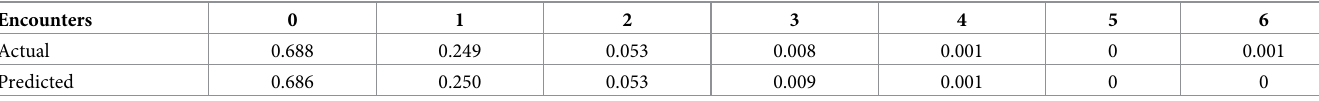
Table 3. Actual and predicted probabilities of encounters. Encounters